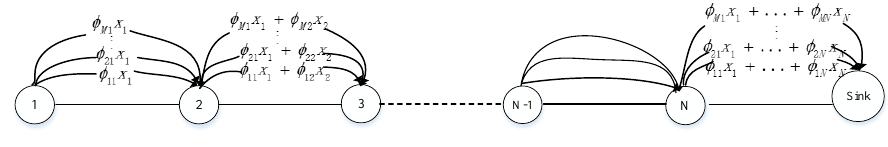
Figure 8. Compressive data gathering (CDG).